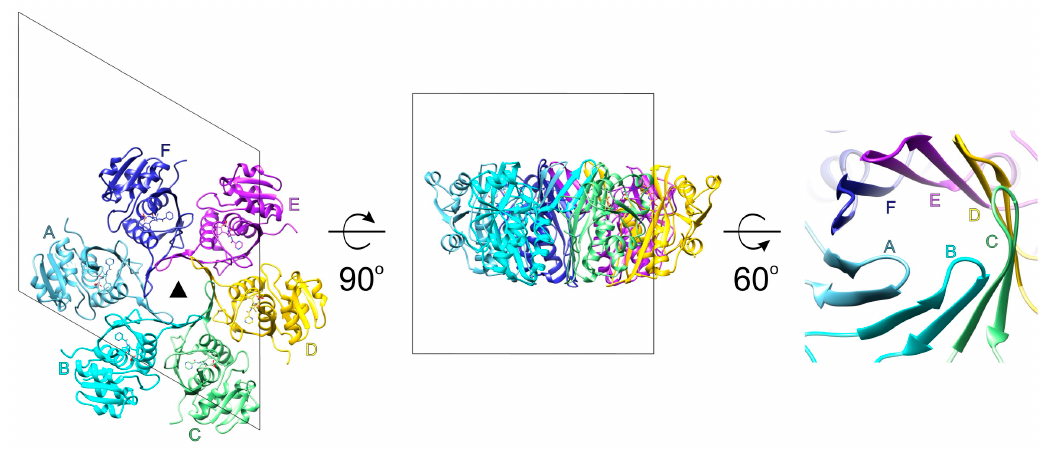
Figure 2. Crystal packing of the protease domain of Bs LonBA. Unit cell of Bs LonBA crystals with six chains of the protease domain of Bs LonBA organized around the crystallographic threefold symmetry axis depicted as a black triangle. The right panel shows the close-up view of the 12-stranded β -barrel created by hairpins β 4– β 5 of the six protease domains labeled A–F. The overall fold of the P domain of Bs LonBA resembles the equivalent domains of enzymes belonging to A, B, and C subfamilies of Lon proteases. In Bs LonBA it consists of a single polypeptide chain of ~200 amino acids, which forms 11 β -strands and seven heli- ces (Figures 3 and S2). The molecule can be divided into two subdomains with a linking fragment comprising residues 460–467. The core of the first subdomain is built of a 4- stranded β -sheet and three helices. A mixed β -sheet consisting of an N-terminal β -hairpin ( β 1– β 2), β 6, and β 3 forms the back wall. The protruding part of the subdomain is formed by another β -hairpin ( β 4– β 5), which participates in the formation of the central β -barrel of the hexamer. It precedes in the sequence the longest helix α 1, which runs on the front side of the mixed β -sheet. Helix α 1 and a short helical turn α 2 (directly preceding β 6 in the sequence) participate in the inter-protomer interactions with the back wall of the neighboring unit of the hexamer. Helix α 1 also interacts with helix α 3, which runs in the central part of the P domain and leads to the second subdomain. This subdomain includes a central three-stranded parallel β -sheet ( β 7– β 10– β 11) flanked by helix α 7 from the bottom side and by helices α 4 and α 6 from the top side. A short helix α 5 directly follows strand β 10. The subdomain has also an extended loop with two very short β -strands ( β 8– β 9), which are placed above the N-terminal side of the α 3 and protrude towards α 1, partici- pating in interactions with the neighboring protomer.